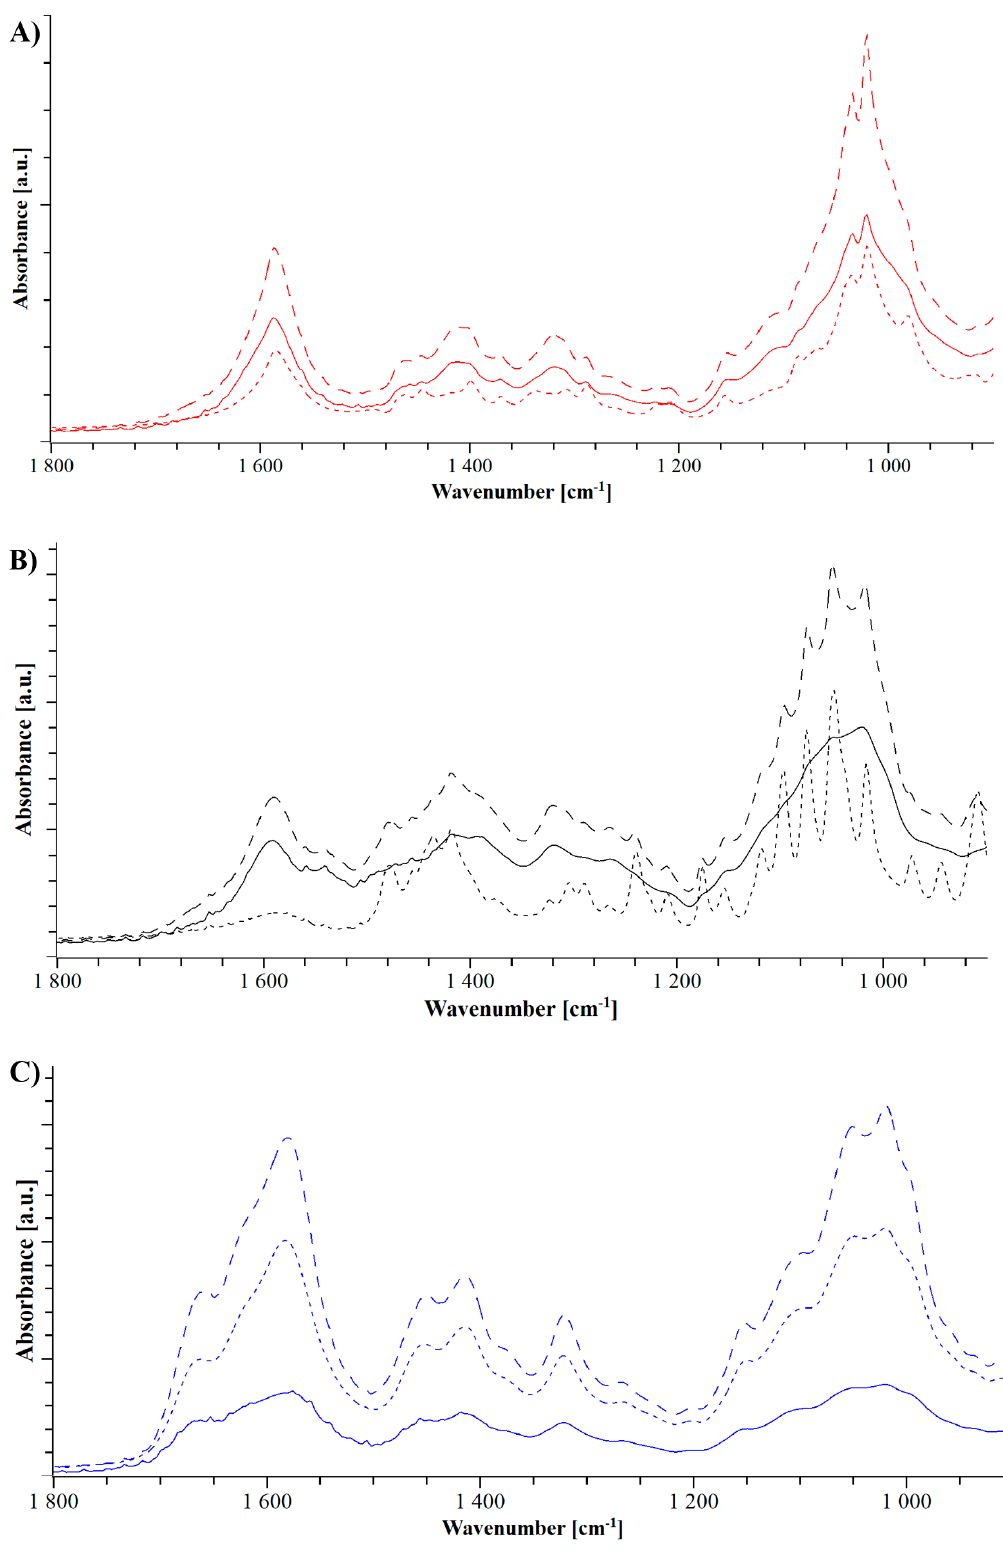
Figure 8. FTIR spectrograms of NaCMC and TRIS ( A , red), meglumine ( B , black), and urea ( C , blue). Dotted lines represent the physical mixture, dashed lines represent the solvent evaporates and the extrudates are shown in solid lines.